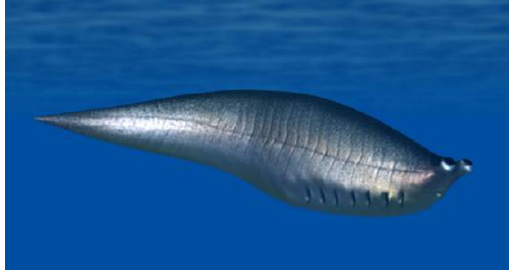
Figure 2. Metaspriggina walcotti . Length of animal 10 cm. PaleoArt credit: Nobu Tamura. Used here per CC BY-SA 4.0.